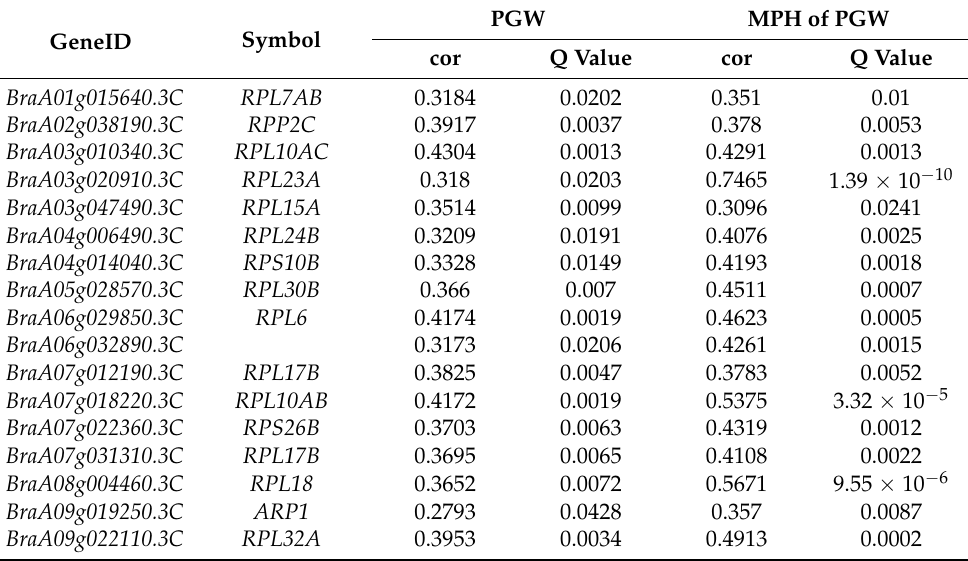
Table 7. Correlation between parental gene expression levels in ribosome metabolic pathwayand plantgrowth weight in hybrids.